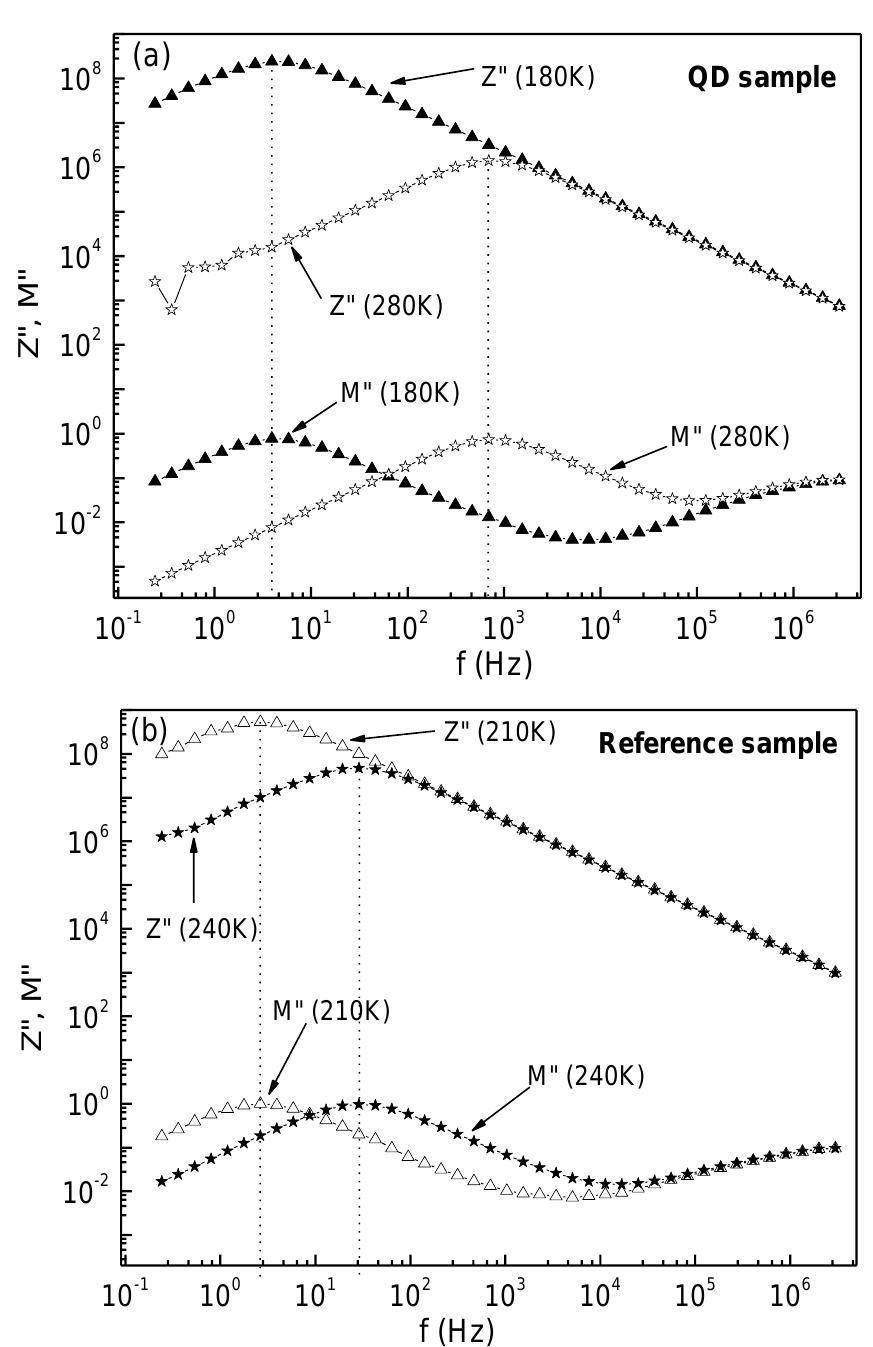
Figure 6. Comparison of plots of the imaginary parts of electric modulus and impedance vs. frequency for the quantum dot ( a ) and reference sample ( b ). For both samples, the maxima correspond to the same frequency.